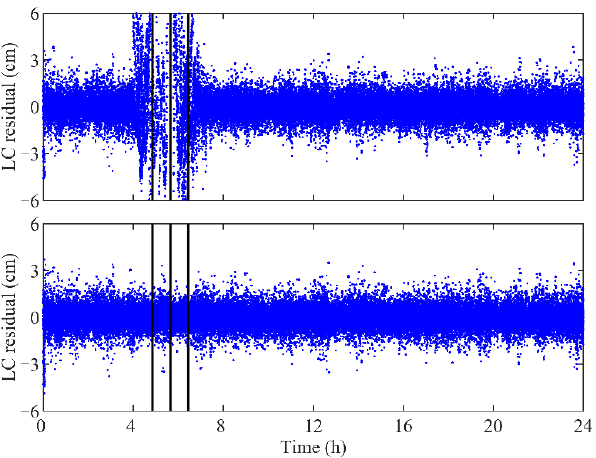
Figure 8. LC residuals of GPS ‐ based POD for TH ‐ 2A without maneuver estimation ( top panel ) and those with maneuver estimation ( bottom panel ) on DOY 314, 2019. The vertical bars denote the centers of the thrust execution periods. Residuals beyond ±6 cm are not shown in the top panel.